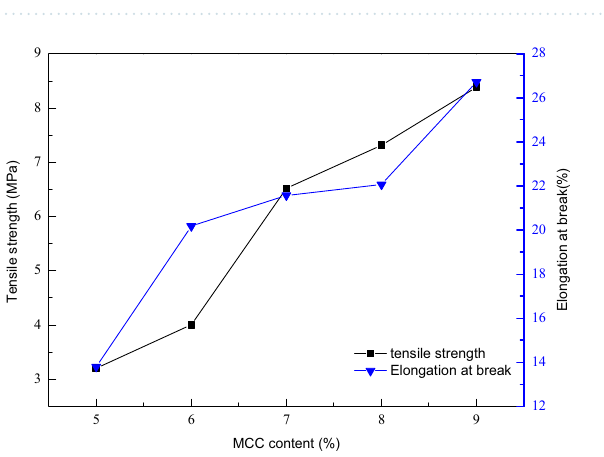
Figure 3. TG and DTG curve of A (standard MCC sample), B ( R. rubescens MCC) and C (MCC membrane). ( a ) TG, ( b ) DTG.